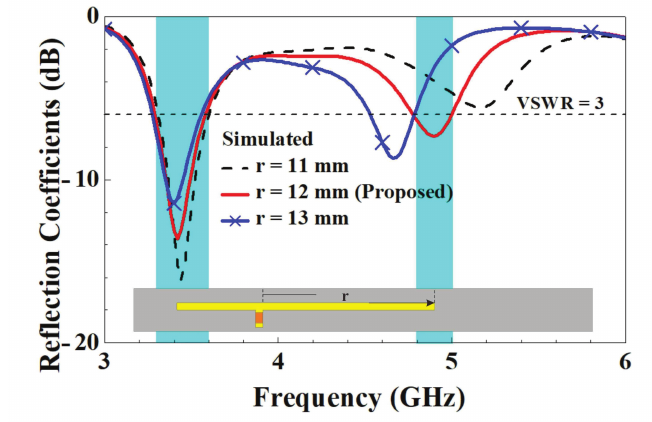
Figure 14. Comparison of simulated reflection coefficients with changes in parameter r